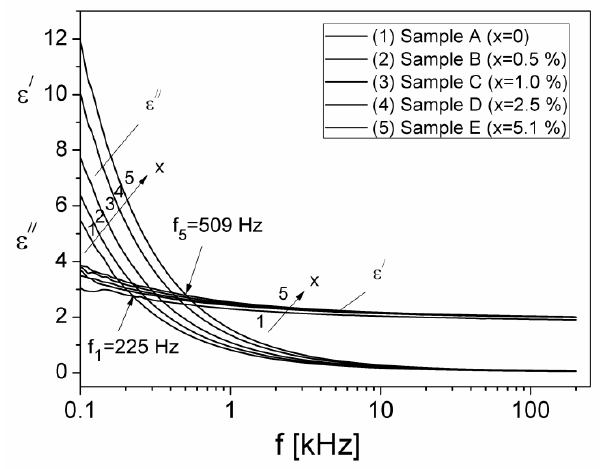
Figure 10. The frequency dependence of the real, ε′ , and imaginary, ε″ , components of the complex dielectric permittivity of the composite samples containing different volume fractions, x, of the Al particles.